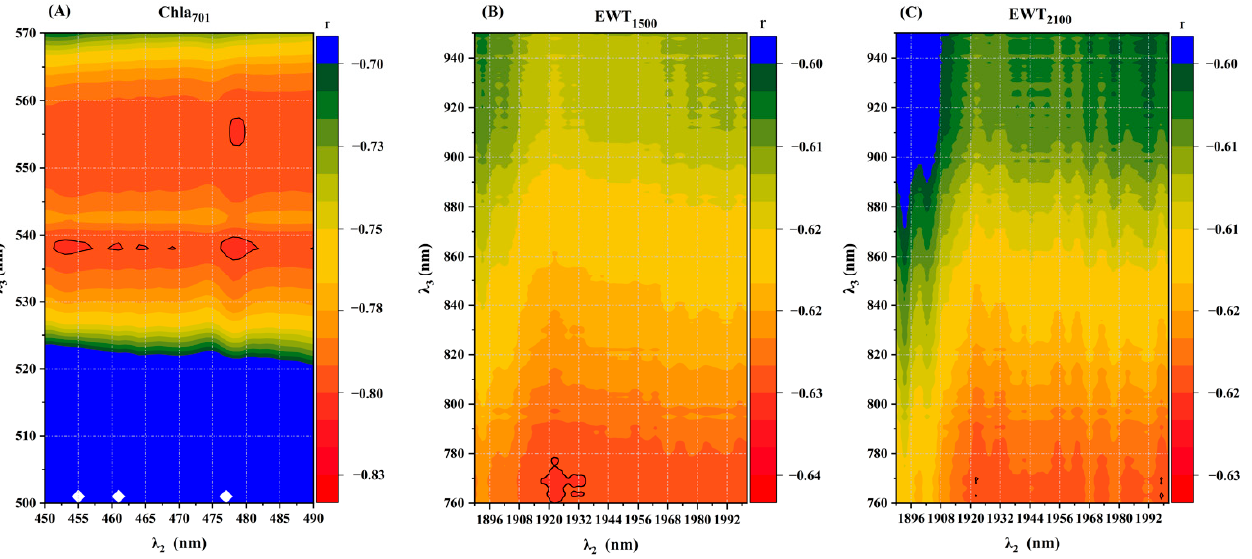
Figure 7. Correlation matrix between physiological spectral indices of cotton leaves under VW stress and the degree of VW disease. ( A ) Chla 701 , ( B ) EWT 1500 , ( C ) EWT 2100 .